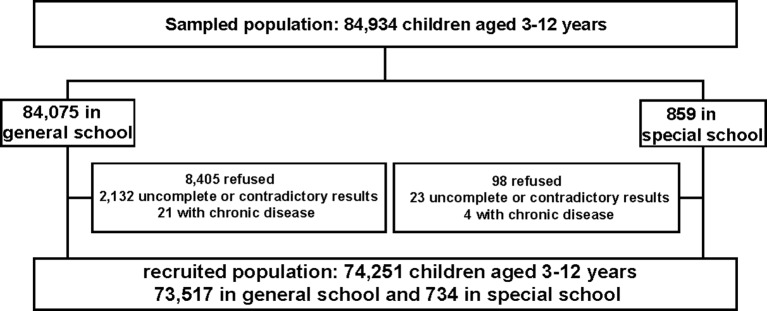
Detailed participation diagram.